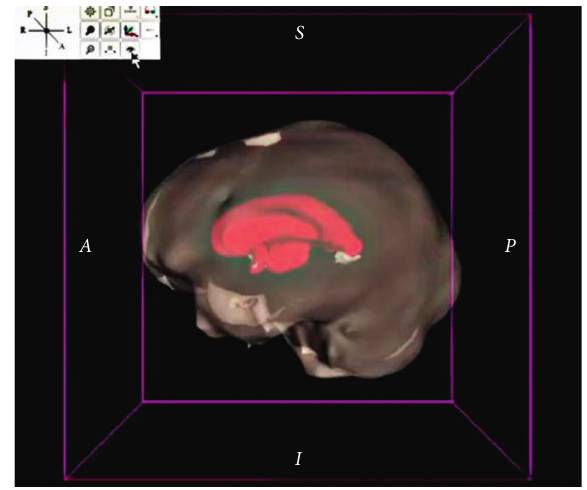
Figure 3: Schematic diagram of intracranial hematoma extraction.